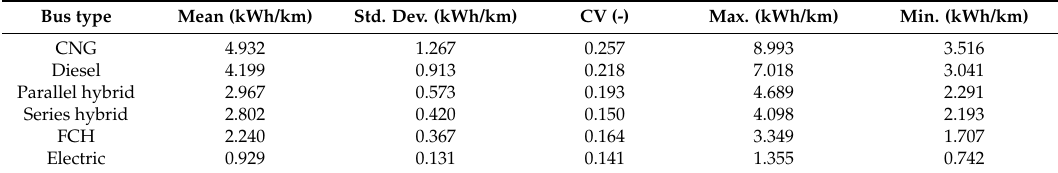
Table 11. Energy consumption statistics on the 19 measured cycles presented in Section